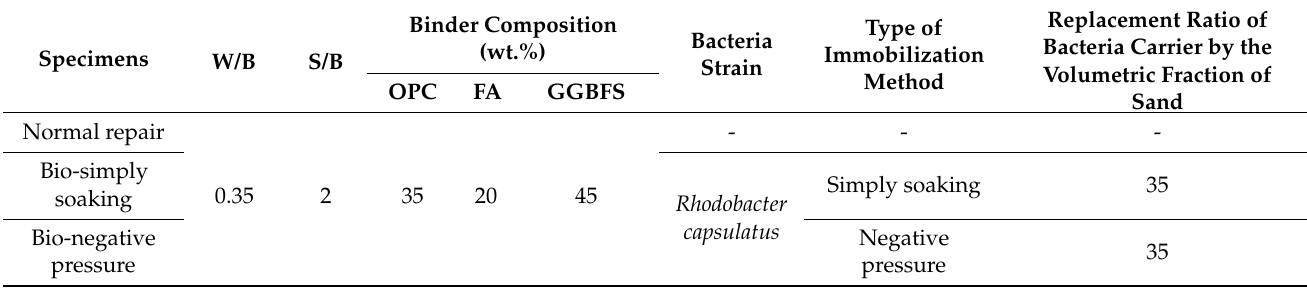
Table 2. Mix proportions of bio-coating materials’ immobilization